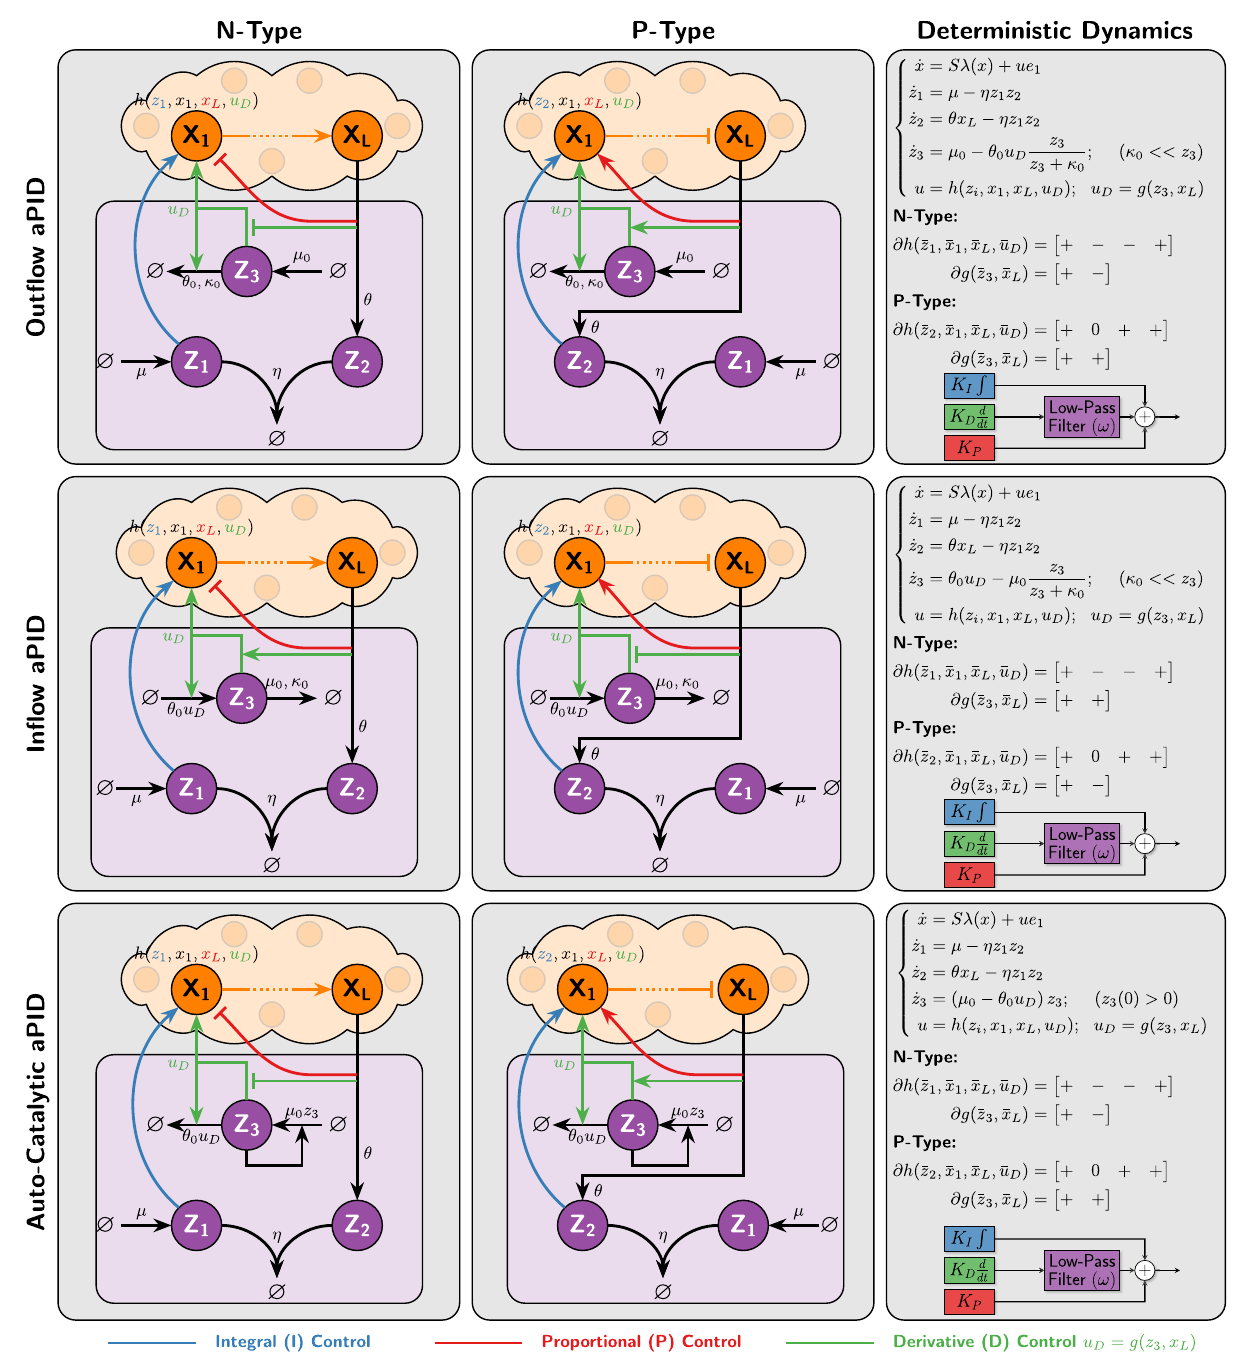
Fig. 10 PID controllers using integral-based differentiators. Three differentiators are constructed based on three different integrators. The differentiators appended to the a PI controllers of Class 1 (see Fig. 3) give rise to another collection of a PID controllers of both N- and P-types. The in fl ow and out fl ow a PID controllers are based on integrators realized via zeroth-order degradation reactions 58,57 . It is shown in Supplementary Information Section 7 that if these degradation reactions are tuned to operate in a saturating regime ( κ 0 < < z 3 ), then a low-pass fi ltered derivative action is mathematically realized. The difference between the out fl ow and in fl ow a PID controllers is that the feedback action u D ≔ g ( z 3 , x L ) which approximates the derivative of x L enters through a degradation and production reaction of the additional controller species Z 3 , respectively. In contrast, the auto-catalytic a PID controller is based on an auto-catalytic integrator 24 where the additional control species Z 3 produces itself. It is shown that for this component to properly function as a differentiator, the initial concentration of Z 3 has to be non-zero and g has to be designed such that g (0, x L ) = 0 (see Supplementary Information Section